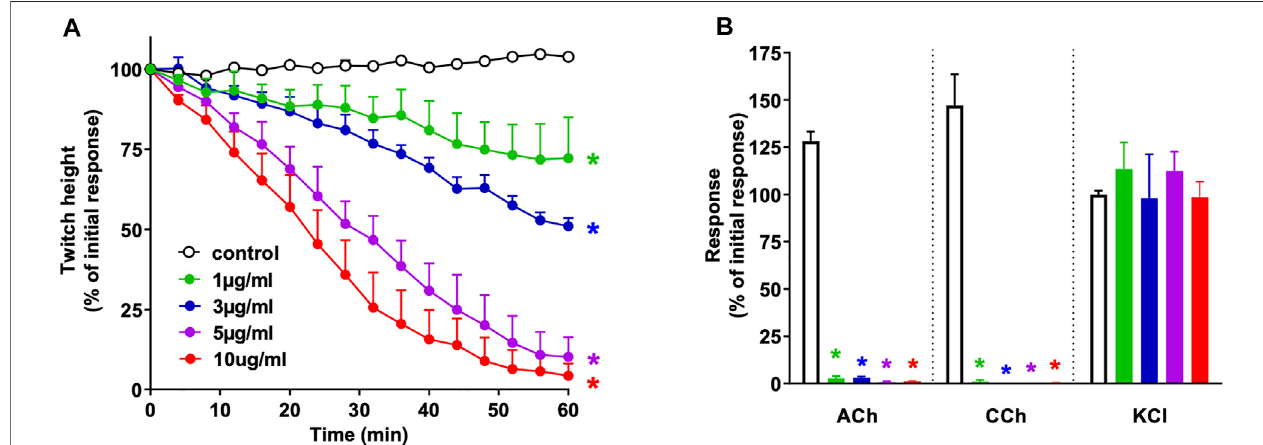
FIGURE 1 | Concentration-dependent in vitro neurotoxicity of N. naja venom (1 – 10 μ g/ml) on (A) indirect twitches and (B) responses to exogenous agonists ACh (1 mM), CCh (20 µM) and KCl (40 mM) in the chick biventer cervicis nerve-muscle preparation. * p < 0.05, signi fi cantly different from (A) control at 60 min (one-way ANOVA; n = 4) or (B) pre-toxin response to same agonist (paired t -test, n = 4).